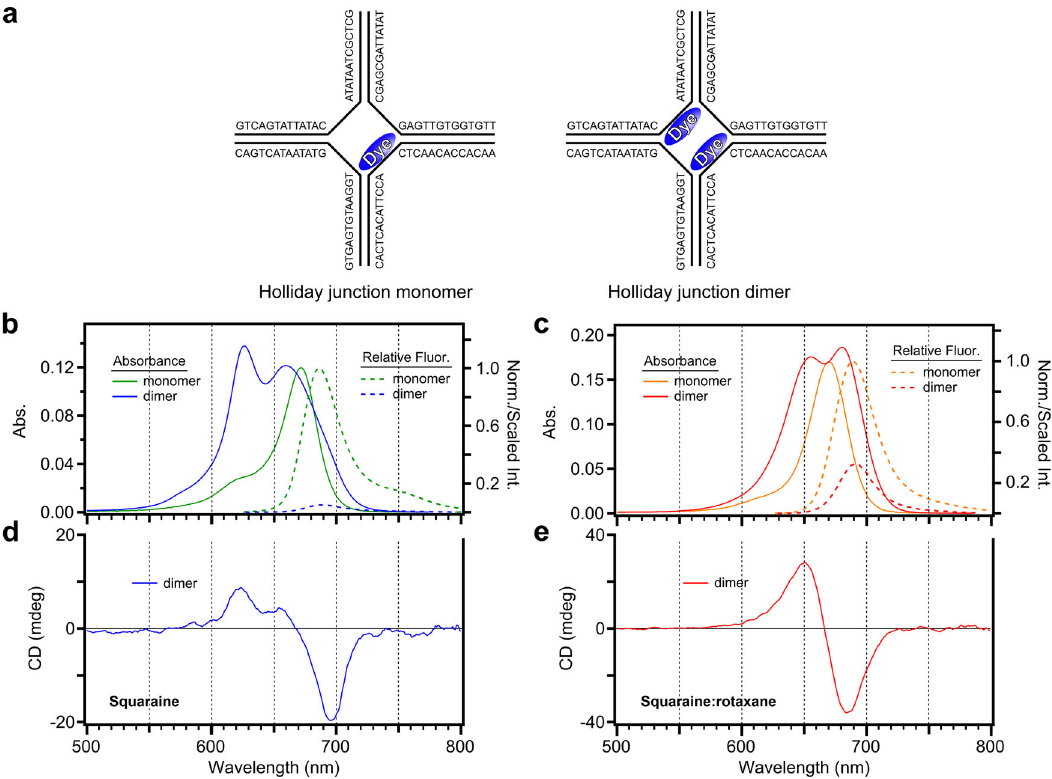
Fig. 2 Schematic representation of SQ (left panels) and SR (right panels) dimers templated using a DNA Holliday junction and their corresponding steady-state absorption, fl uorescence emission, and CD spectra. a Representative schematic of the four-armed DNA Holliday junction used to template the formation of monomers and transverse dimers. The schematic is intended to depict the positions of the attached dyes in the DNA sequences, not the conformation of the Holliday junction. Serinol linkers that attach dyes to the DNA backbone (Supplementary Note 1) are not shown. b , c Steady-state absorption spectra and fl uorescence emission spectra for the SQ and SR dimer solutions. Absorption spectra and fl uorescence emission spectra are also shown for the corresponding monomer solutions. To account for differences in the amount of light absorbed by each solution, the measured spectra were divided by the absorptance of each solution at the excitation wavelength. The spectra of the monomer solutions were thereafter normalized to the shortest wavelength band, and the spectra of the corresponding dimer solutions were scaled using the same factor. d , e CD spectra for the SQ and SR dimer solutions. The CD spectra of the corresponding monomer solutions are achiral and therefore featureless in the same spectral region and have been